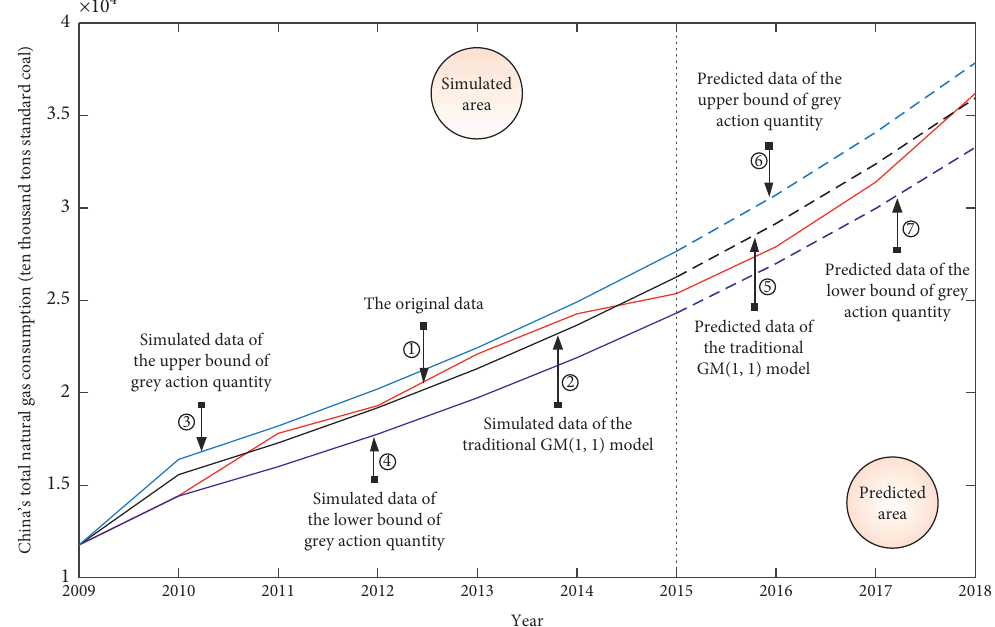
Figure 7: Comparisons of the original data and various simulation and prediction